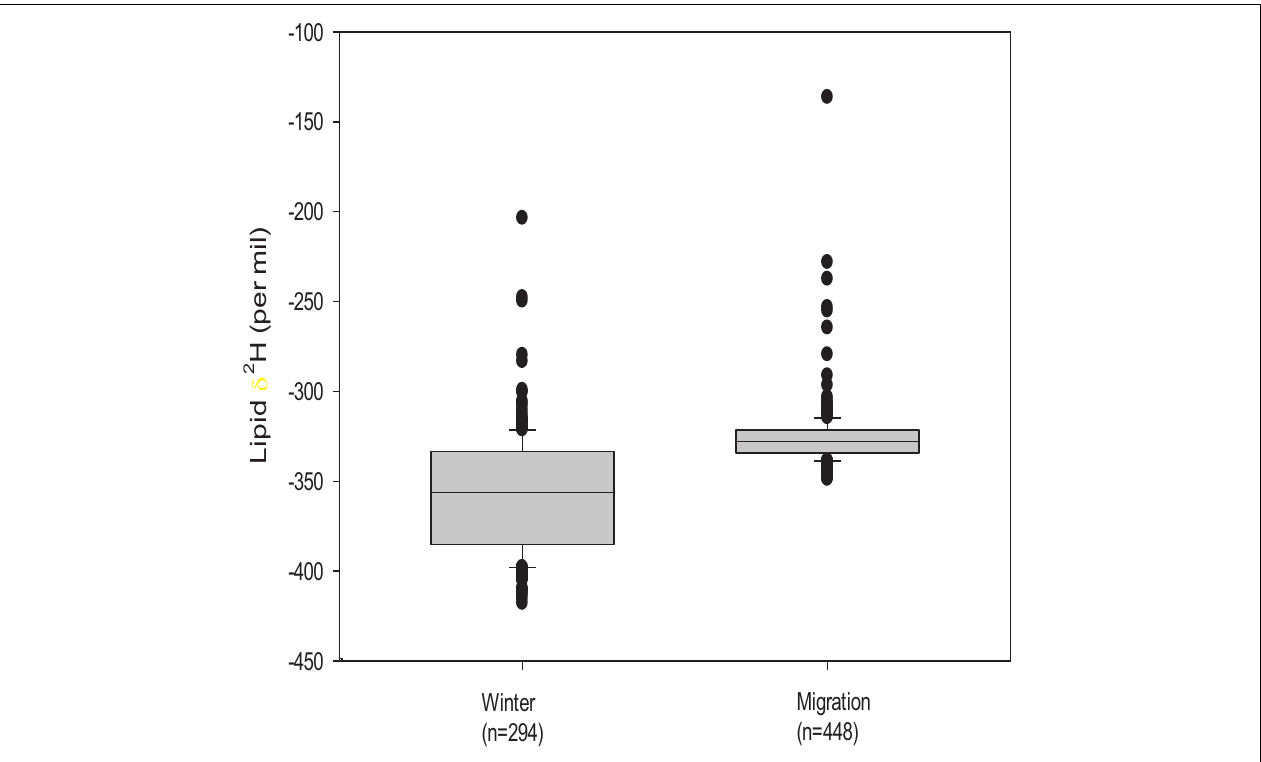
) between migrating and overwintering monarch butterflies based on all lipid samples analyzed across sites and years FIGURE 5 | Difference in lipid δ 2 H values ( ( Supplementary Table S1 ). Not all specimens were run for wing δ 2 H analyses and so sample sizes may differ from those depicted in Figures 3 , 4 (cid:104)